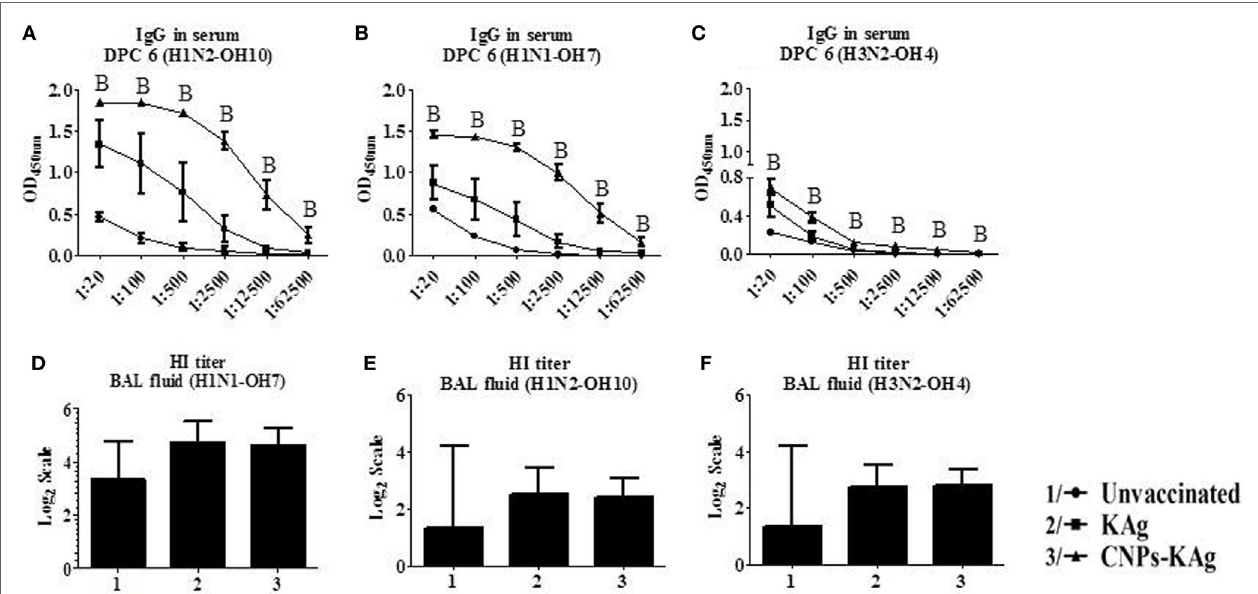
FigUre 6 | Serum IgG response and bronchoalveolar lavage (BAL) fluid hemagglutination inhibition (HI) antibody titers in pigs vaccinated with chitosan nanoparticles (CNPs)-KAg at day post-challenge 6. Specific IgG antibody response in serum and BAL fluid HI titers against H1N2-OH10 (a,e) , H1N1-OH7 (B,D) , and H3N2-OH10 (c,F) influenza A virus (IAVs). Data represent the mean value of three to five pigs ± SEM. Statistical analysis was carried out using Kruskal–Wallis test followed by Dunn’s post hoc test. Asterisk refers to the statistical significant difference between the indicated two pig groups (* p < 0.05). In antibody dilution curves (a–c) , A, B, and C refers to significant difference between unvaccinated vs KAg vaccinates, unvaccinated vs CNPs-KAg vaccinates, and KAg vs CNPs-KAg vaccinates, respectively, at the indicated dilution.